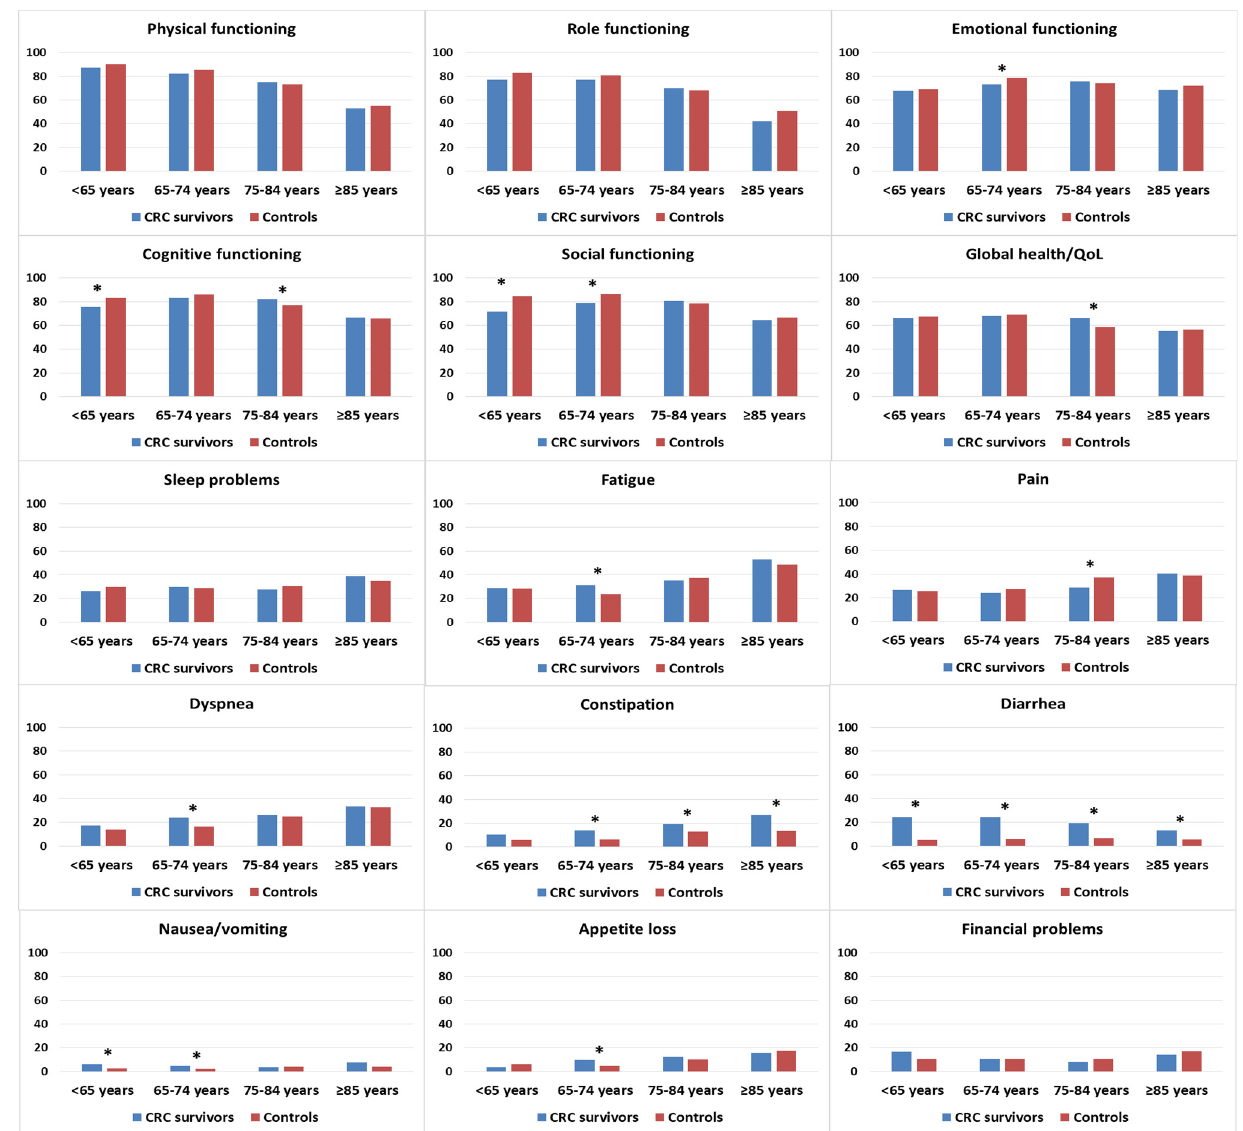
Figure 3. Mean EORTC QLQ-C30 scores of colorectal cancer (CRC) survivors and controls, stratified by age at survey. Models are adjusted for age at survey, sex, and education. Asterisks (*) indicate significantly differences ( p < 0.05) between the subgroups. All results are based on 25 imputations of missing values.